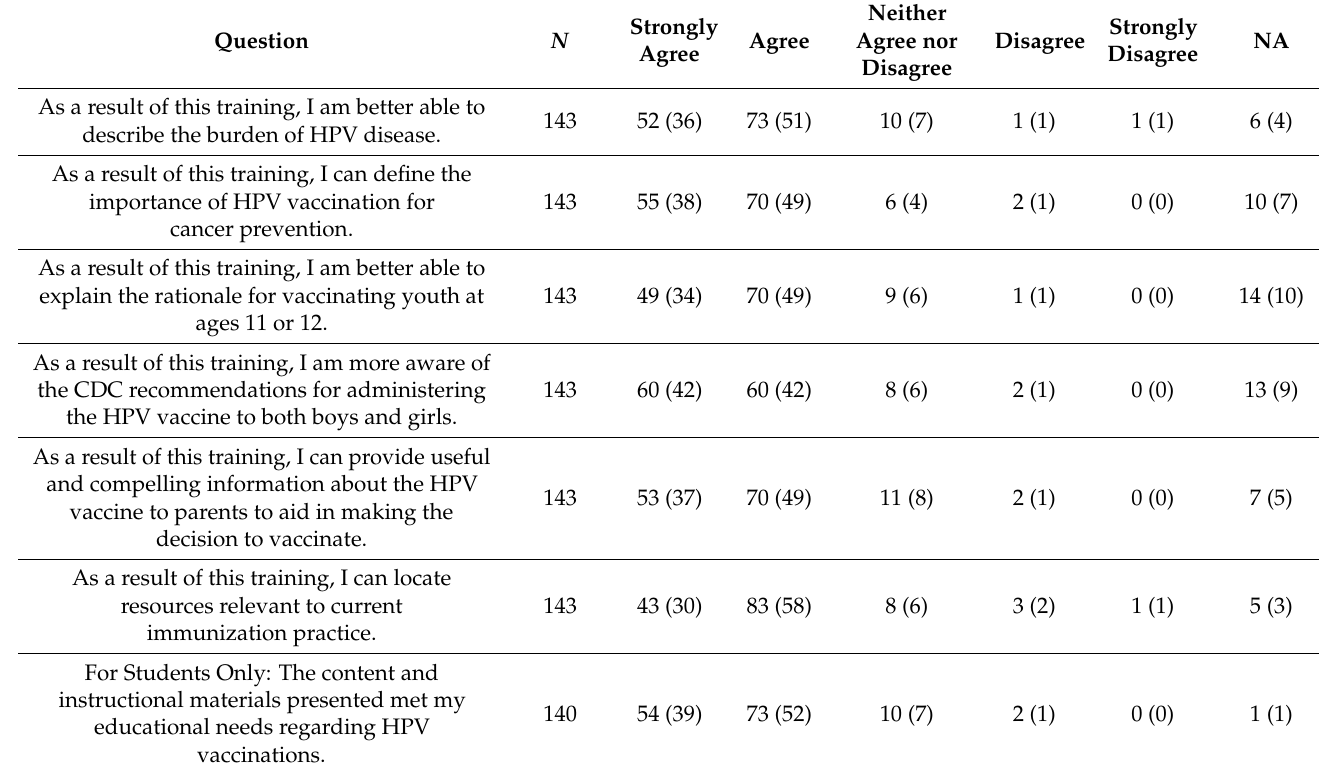
Table 4. Responses to